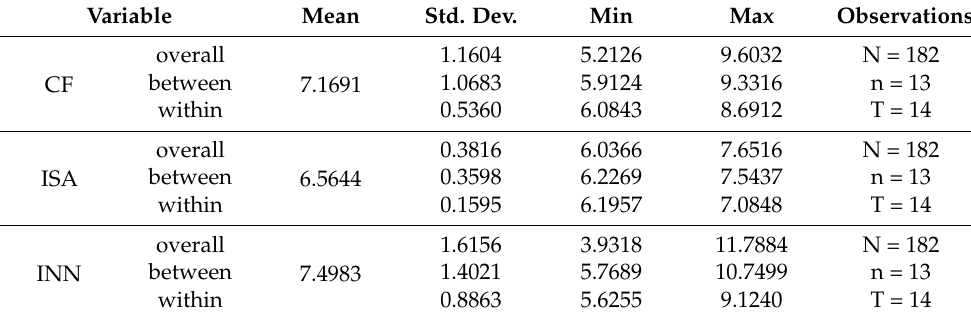
Table 2. Descriptive statistics.